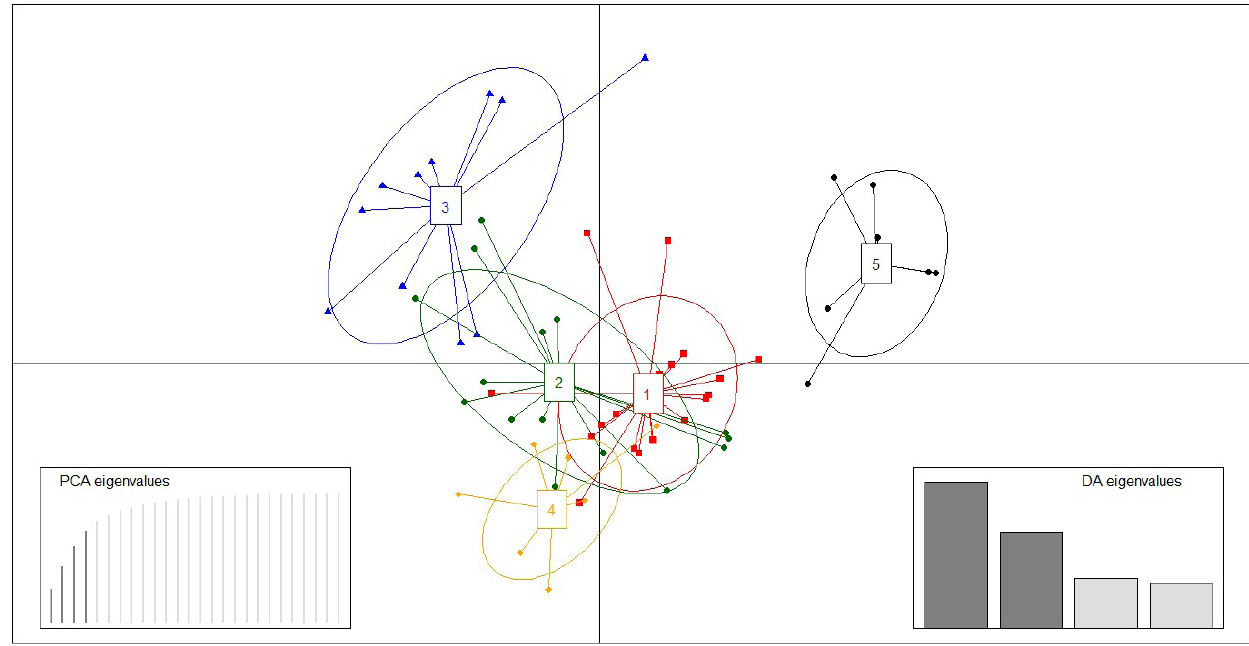
FIGURE 3 | Discriminant Analysis of Principal Components (DAPC) scatterplots for the five Rhinoptera bonasus microsatellite genotypes. Dots represent individuals, whereas coloured ellipses correspond to geographical populations. Collection areas: Santa Catarina (1, red), São Paulo (2, green), Rio de Janeiro (3, blue), Pernambuco (4, orange) and Pará (5,